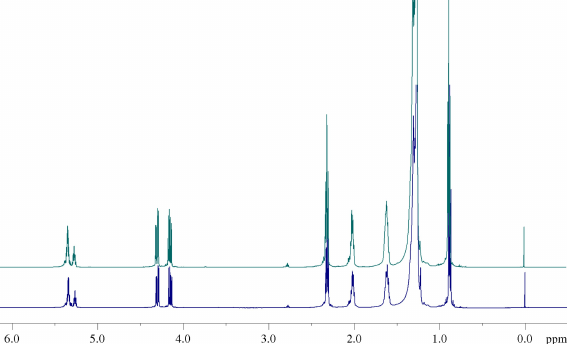
Figure 6. Comparison between 1 H NMR spectra (500 MHz, 298 K, in CDCl 3 ) of natural CB (sample A, blue line) and one of the modified fats (sample B, green line) to highlight the high similarity of the protonic profile.